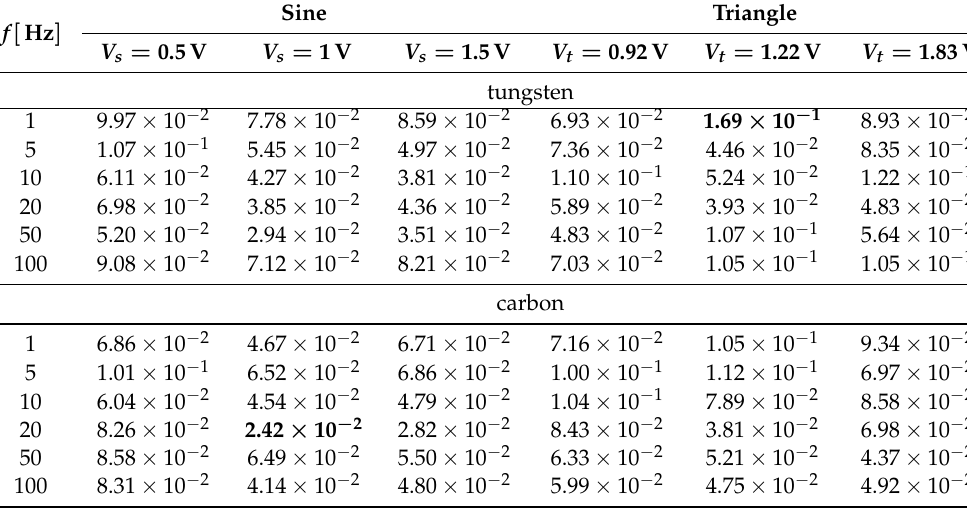
Figure 4. Distribution of the deviation factor for the measured data. The graphs correspond to the samples presented in Figure 2. ( a ) Tungsten dopant; ( b ) Carbon dopant. Table 1. The values of the error ε defined in Equation (9) of the acquired signals for two tested kinds of memristors and different combinations of voltage amplitude, shapes, and frequencies of the excitation signals. The highest and lowest numbers are indicated with bold font